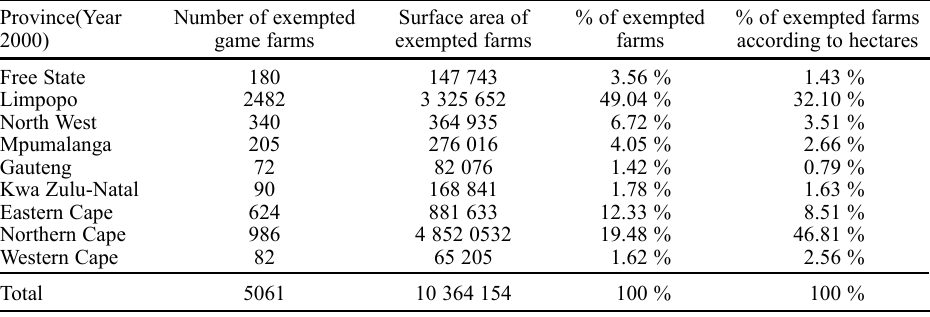
Number of exempted game farms in South